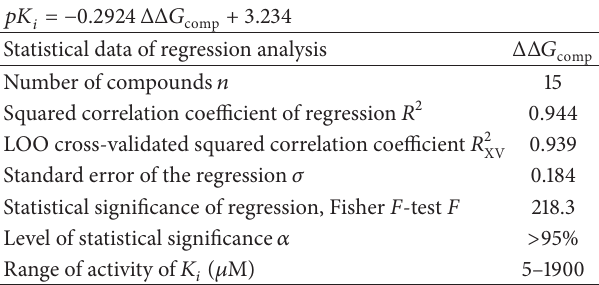
Table 3: Statistical information on regression analysis of correlation for the training set between ΔΔ𝐺 ( 𝑝𝐾 𝑖 ) respectively against TMPK mt